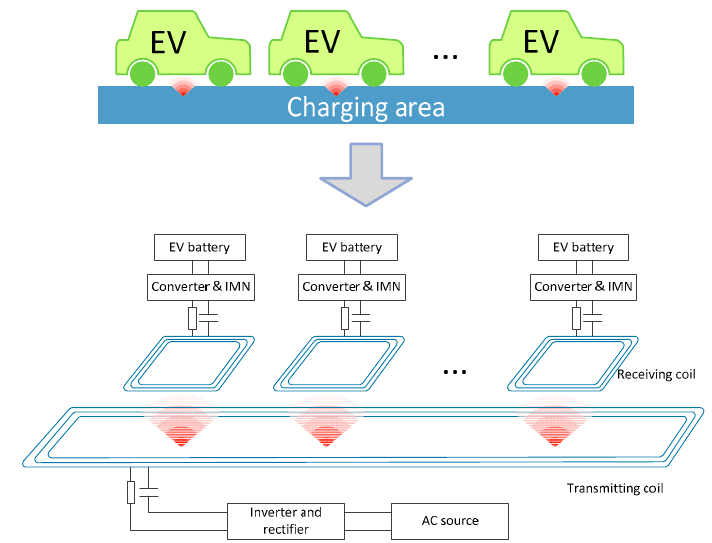
Figure 1. Schematic diagram of the long-track dynamic wireless power transmission (DWPT) system. EV—electric vehicle; AC—alternating current; IMN—impedance matching network.